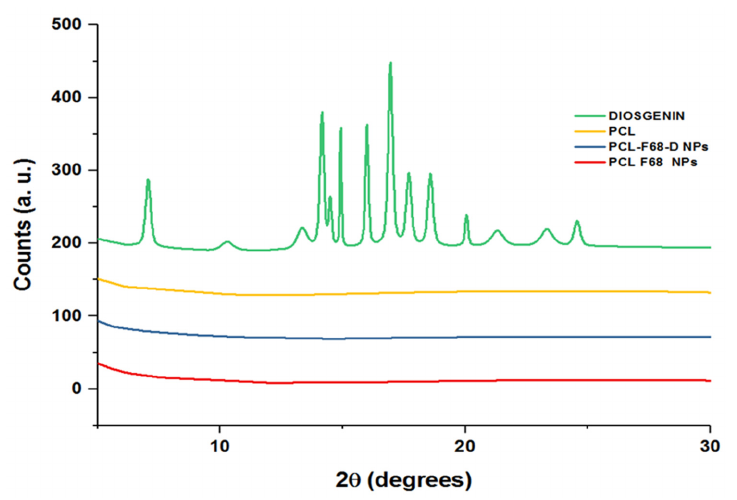
Figure 2. X-ray diffraction (XRD) spectra of PCL, Diosgenin, PCL-F68-NPs, and PCL-F68-D-NPs.